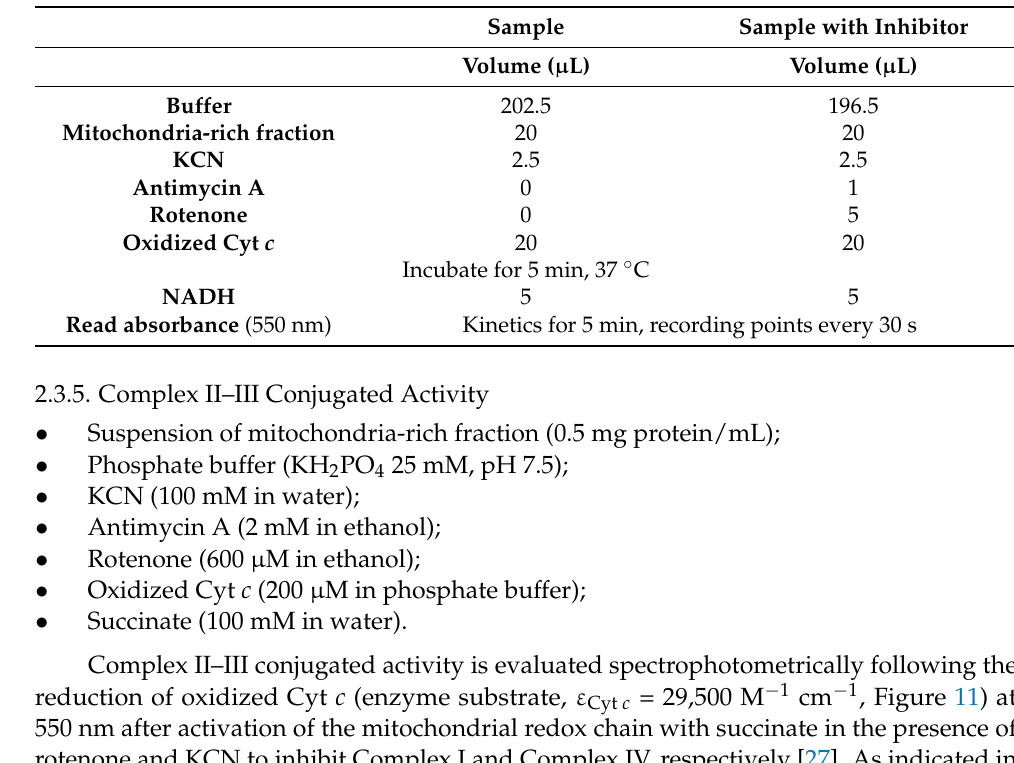
Table 8. Conditions and flow setup for Super-complex I–III activity assay.